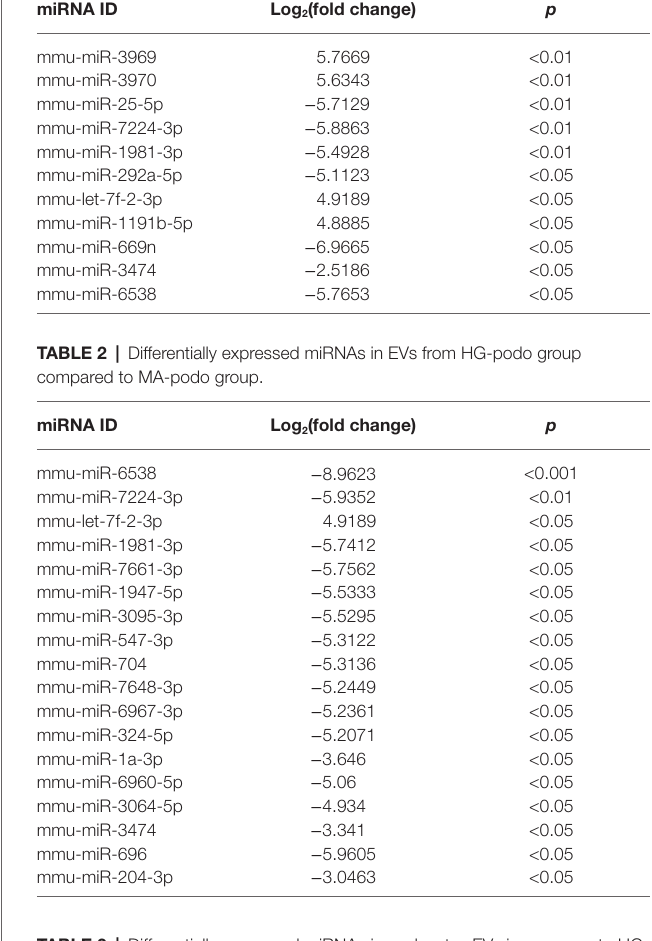
TABLE 3 | Differentially expressed miRNAs in podocytes EVs in response to